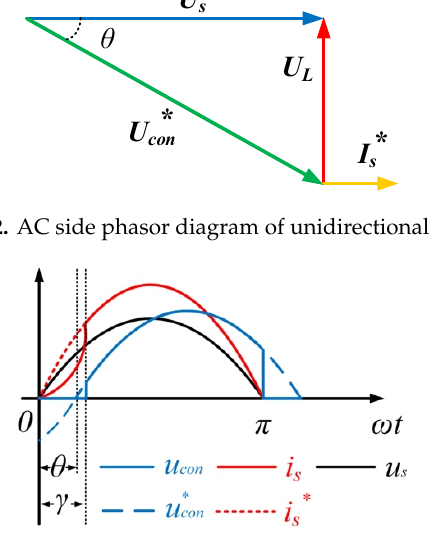
Figure 13. Waveform of voltage and current in AC side.